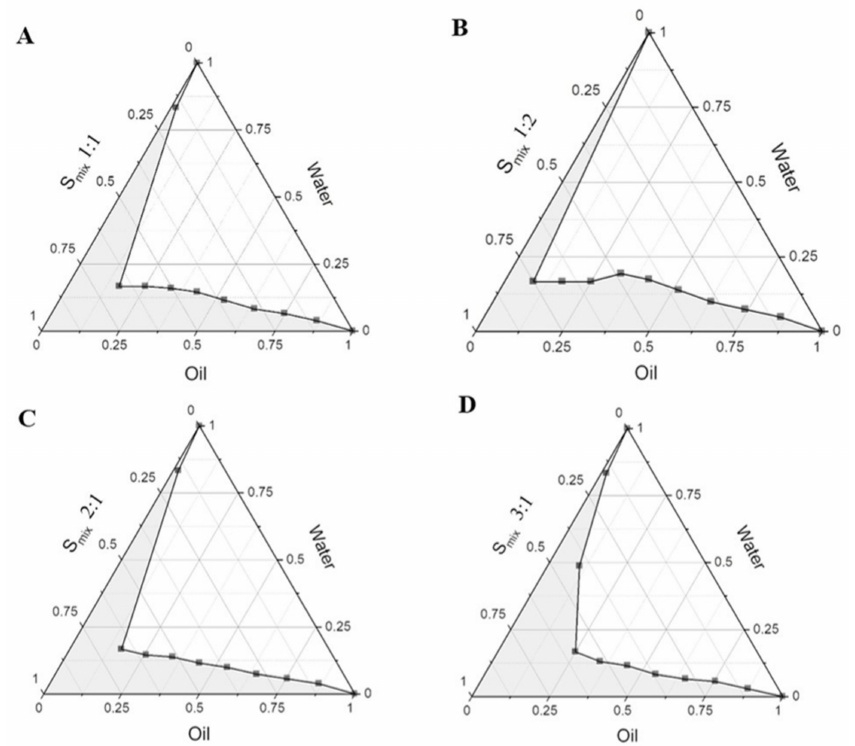
Figure 2. Pseudo-ternary phase diagram of eugenol, Tween 80, and PEG400 containing various S mix ratios: ( A ) 1:1 with area 33.43%; ( B ) 1:2 with area 31.98%; ( C ) 2:1 with area 34.35%; and ( D ) 3:1 with area